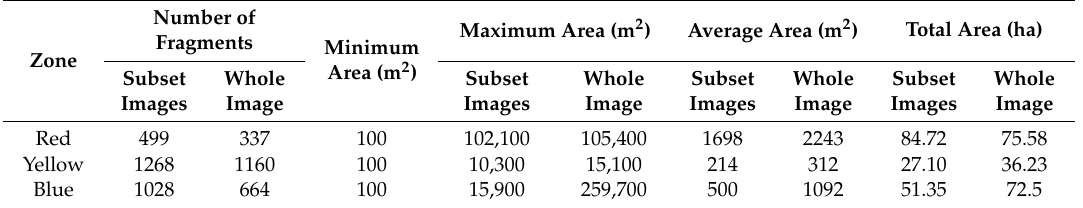
Table 5. Area statistics for the red, yellow and blue zones in the overlaid classification map generated by airborne and field subset Sentinel-2A image as well as airborne image and whole study area Sentinel-2A image.